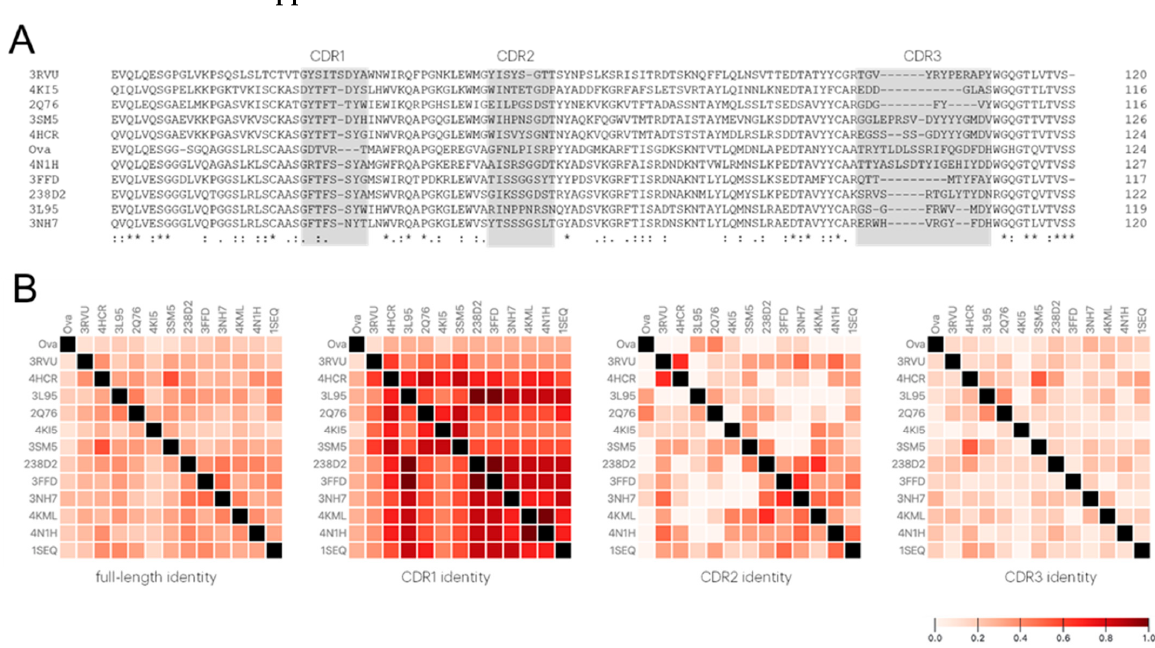
Figure A1. Sequence alignment of all the selected VH domains with 238D2 shows weak sequence identity. ( A ) Linear sequences alignment of 238D2, 3SM5, 4N1H, 3FFD, 4HCR, 3L95, 4KI5, 3RVU, 2Q76, 3NH7, 4KML, 1SEQ, and the anti-ovalbumin Nb. Similar amino acid residues are shown by an asterisk, amino acids exhibiting strongly similar properties as represented by a “:” and poorly similar residues by a “.”. ( B ) Matrices of the pairwise sequences identities between the 11 antibodies on the full-length sequence and for each of the three CDRs.